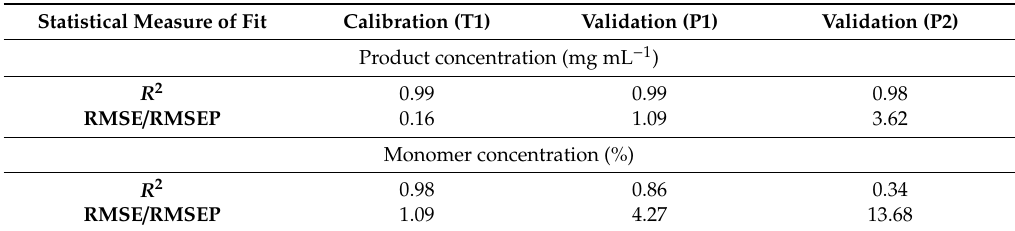
Figure 6. Prediction performance of the PLS model predicting product concentration with ( A ) displaying a parity plot for validation set T1, ( B ) parity plot for calibration set P1, ( C ) parity plot for calibration set P2, and ( D ) confusion matrix that classifies the product concentration predictions above or below 1.5 g L − 1 in comparison to the experimental product concentrations. In the confusion matrix ( D ), the top left cell indicates true positives, the top middle cell indicates false positives, the middle left cell indicates false negatives, and the middle cell indicates true negatives. In each of these matrix cells, the value indicates the number and percentage of samples in each category. In the total matrix cell columns and rows, the total number of samples is given, with the percentage indicating the number of true positives or true negatives. Table 3. Summary of monomer purity and product concentration model fit ( R 2 ), RMSE of calibration set, and RMSEP of two validation